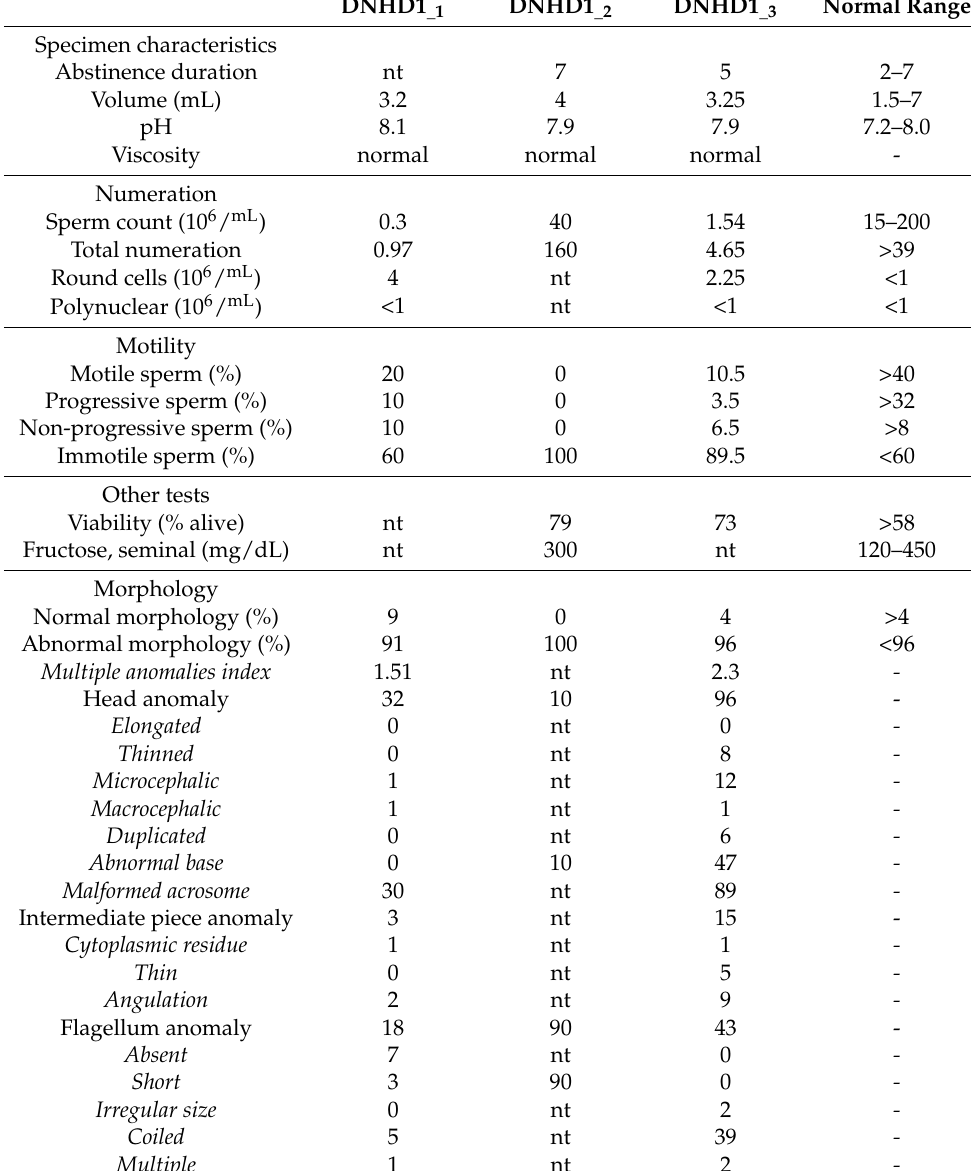
Table 1. Detailed semen parameters for the three patients harboring DNHD1